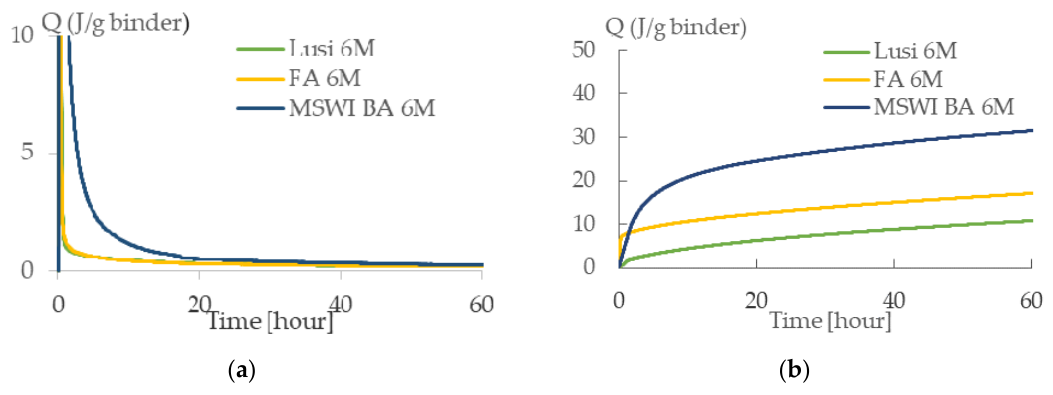
Figure 4. ( a ) Heat evolution of LWA. ( b ) Heat cumulative of LWA.